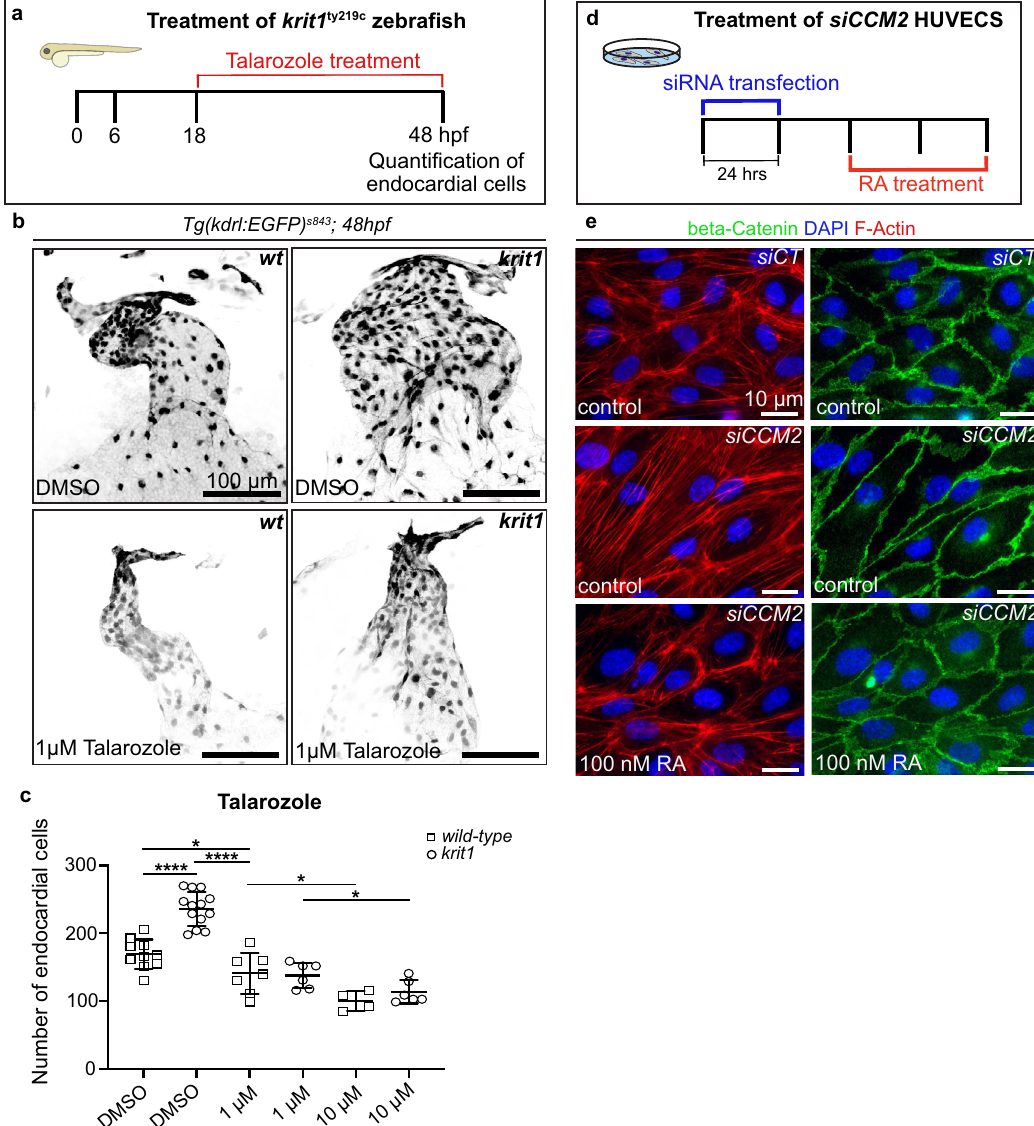
Figure 2. Curative effects upon Talarozole treatment of krit1 mutant zebrafish and retinoic acid treatment of siCCM2 depleted HUVECs. (a ) Treatment scheme for zebrafish from 18 to 48 hpf using Talarozole. Endocardial cell numbers (a readout for CCM-associated cardiac phenotype in zebrafish) were analyzed after treatment in two independent experiments. ( b ) Representative images of zebrafish heart morphologies visualized by the transgene kdrl:EGFP at 48 hpf after treatment. Upper: heart morphology of controls treated with DMSO. Lower: hearts treated with Talarozole. Scale bars: 100 µm. ( c ) Endocardial cell counts at 48 hpf of zebrafish treated with several doses of Talarozole or DMSO (*P < 0.05; ****P < 0.0001 vs. control). Each data point represents one heart. ( d ) Treatment regimen of HUVECS. SiRNA transfection was done for 24 h, followed by treatment with RA 24 h later. Cell morphologies were analyzed after 48 h of incubation and antibody staining. ( e ) Immunohistochemistry of HUVECS for beta-catenin, F-actin, and DAPI. First column: control cells (siCT) with wild-type CCM2 expression. Second column: untreated siCCM2 -depleted HUVECs. Third column: representative image showing siCCM2 HUVECs treated with 100 nM RA. Scale bars: 10